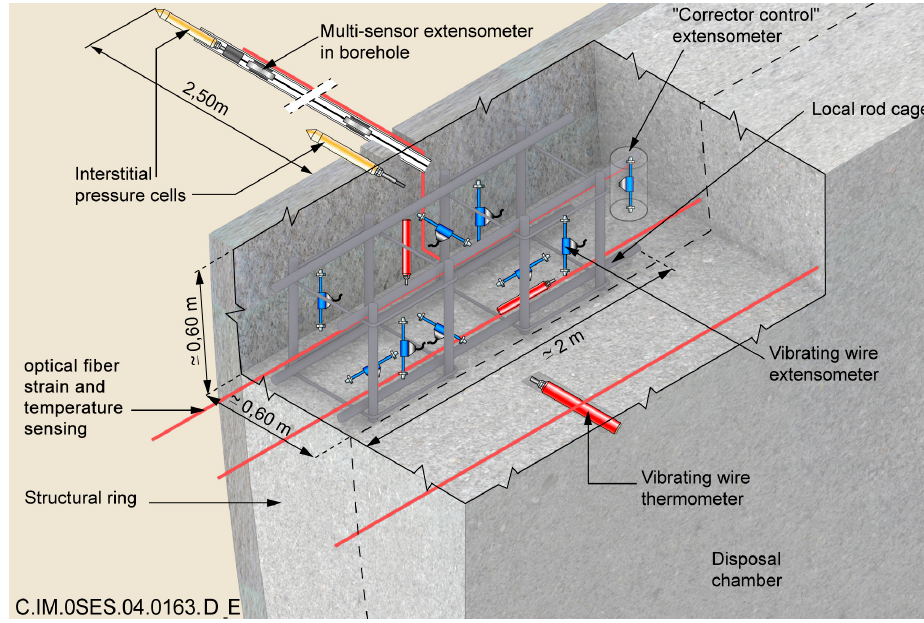
Figure 2. Envisioned monitoring system for ILW-LL repository cells.